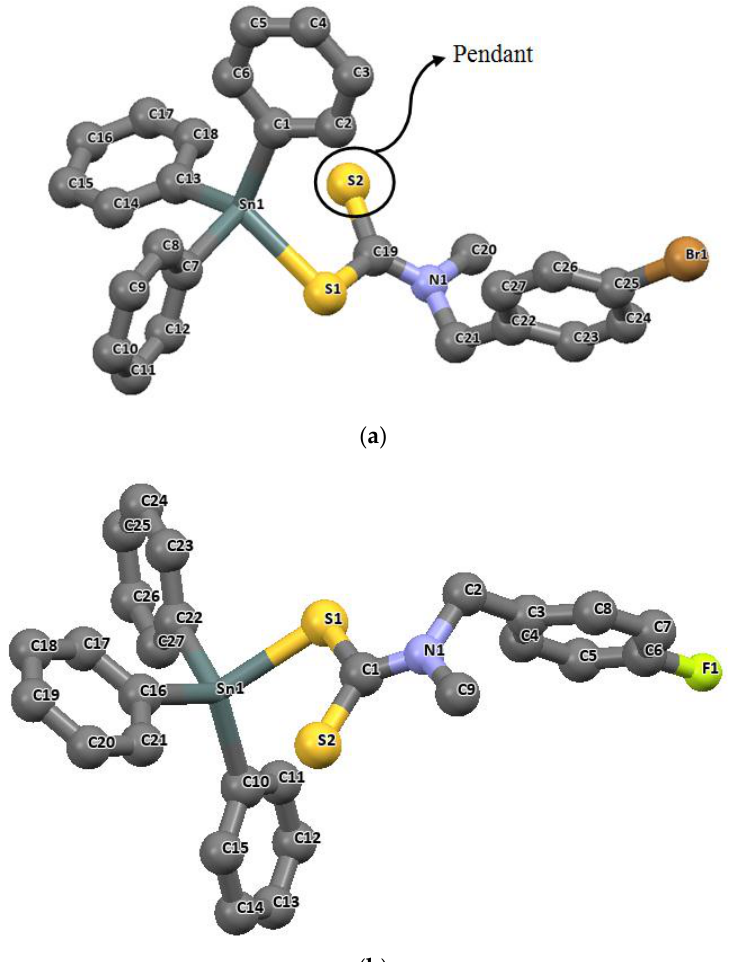
Figure 4. Molecular structures of ( a ) triphenyltin(IV) p -bromo- N -methylbenzylamine dithiocarbamate and ( b ) triphenyltin(IV) N -methylbenzylaminedithiocarbamate with ellipsoidal displacement at 50% probability level (For clarity, H atoms were omitted). Redrawn from [80], with permission from Elsevier (Copyright 2018).